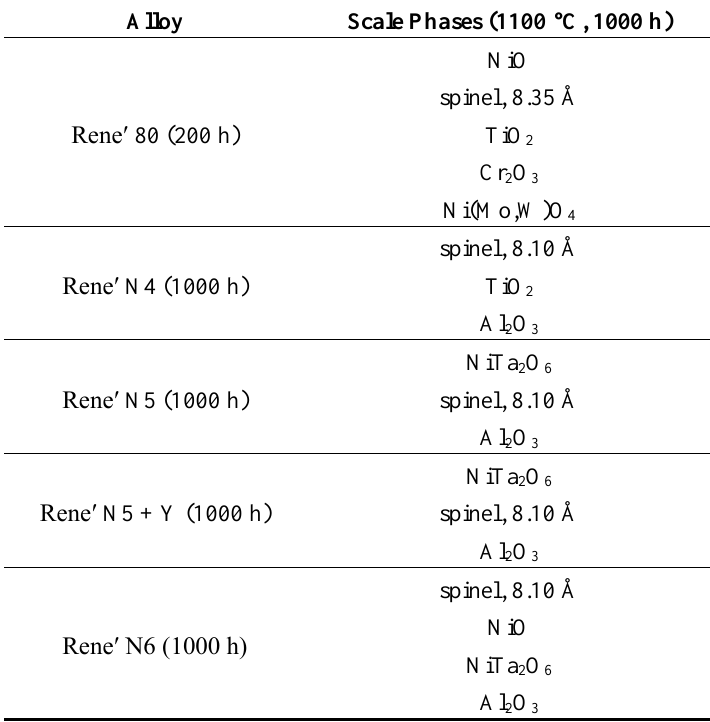
Table 4. XRD analysis of scale phases formed on commercial superalloys after 1000 h cyclic oxidation at 1100 °C corresponding to mass change data in Figure 2. (Listed in order of pattern strength, strongest to weakest).